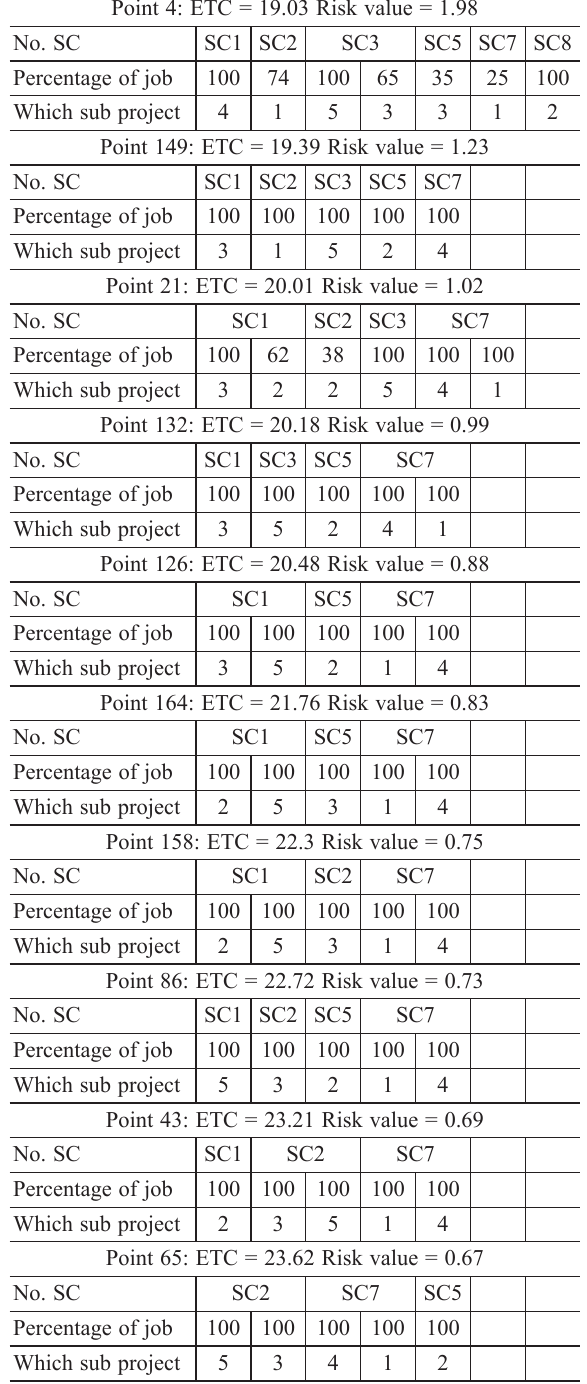
Table 7. Characteristics of portfolio on the efficient